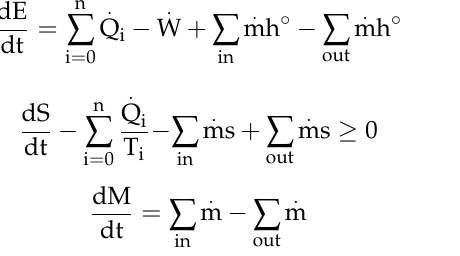
Figure 10. Montage of evolutionary designs that have been predicted and explained based on the constructal law. constructal